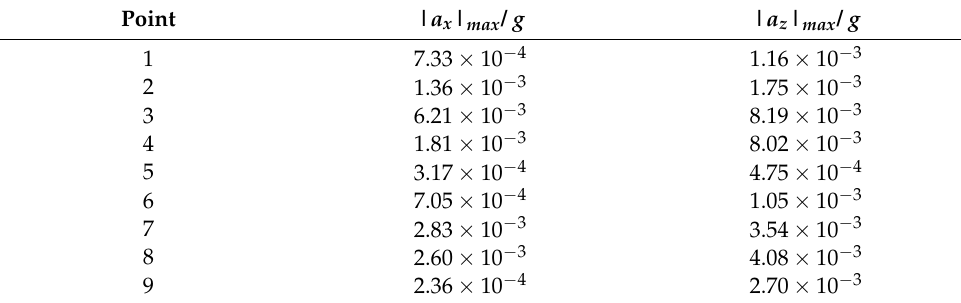
Table 2. Eigenvalue of acceleration of east exhaust inclined